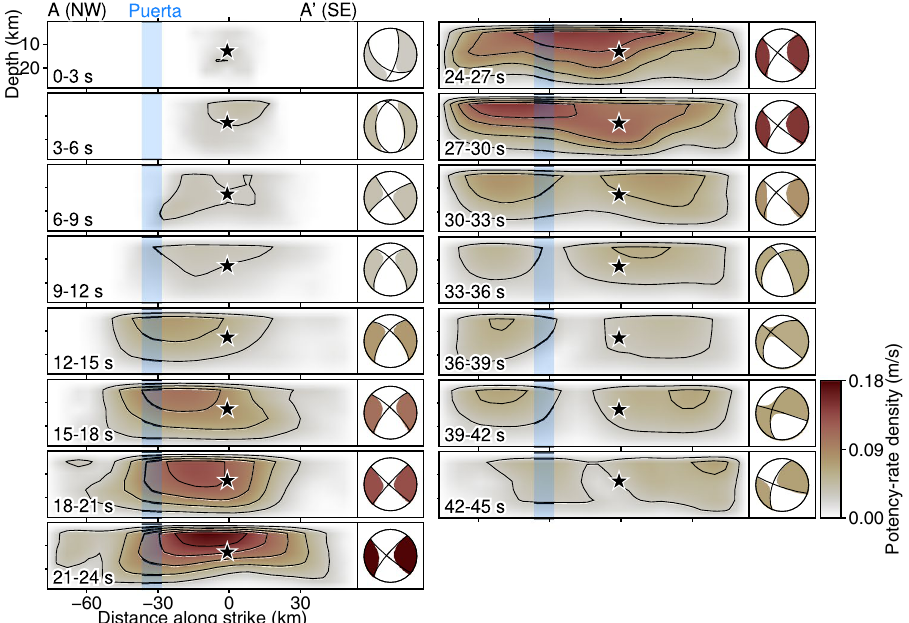
Figure 4. Snapshots of potency-rate density evolution. In each panel, a cross section of the potency-rate density distribution (contour interval 0.03 m/s) is shown on the left. The vertical blue-shaded bar shows the Puerta accommodation zone 12 . The star denotes the hypocentre used for the inversion. In each panel, the total moment tensor obtained by spatially integrating the potency-rate density tensors in the given time window is shown on the right. The colour corresponds to the maximum potency-rate density within the corresponding time window. The total moment tensors are shown as lower hemisphere projections onto the map with north upward. This figure was made with Generic Mapping Tools (v6.2.0) 18